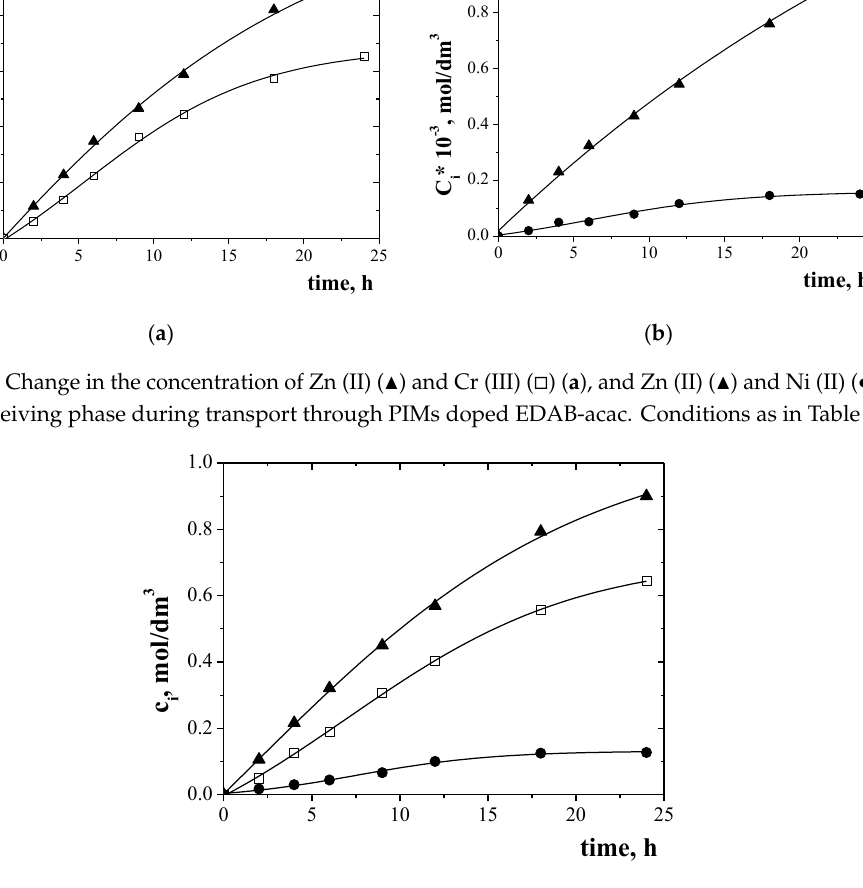
Figure 6. Change in the concentration of metal ions (Zn (II) ( ▲ ), Cr (III) (□), Ni (II) (●)) in the receiving phase depending on the transport time. Conditions as in Figure 5.